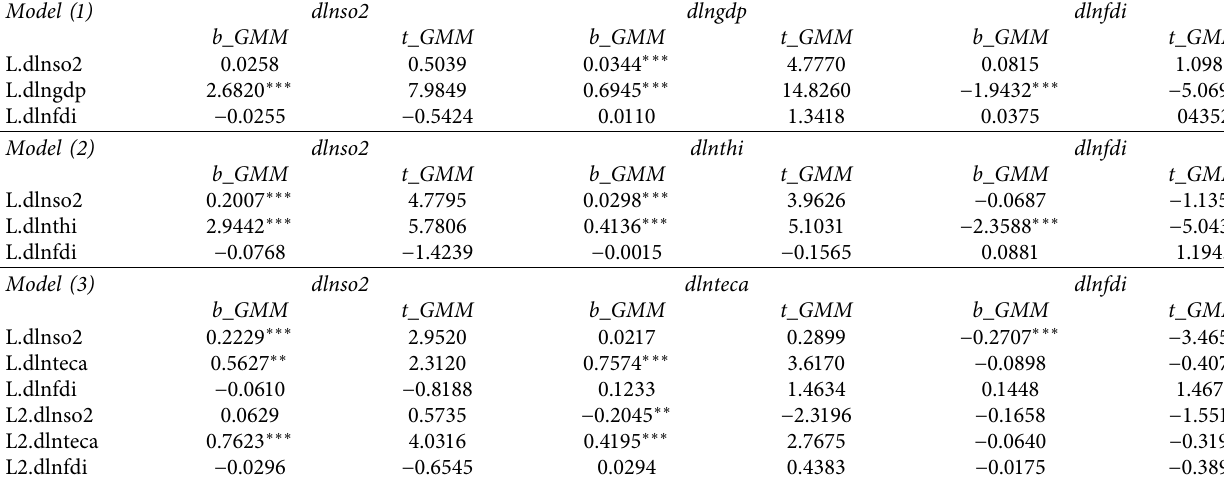
Table 4: PVAR estimation